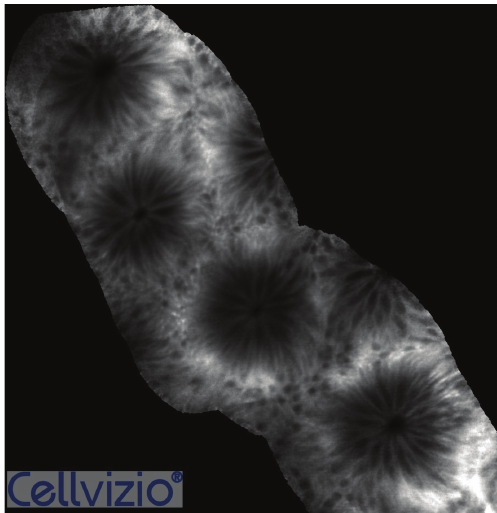
Figure 1: p-CLE fluorescein sodium 10% imaging of the normal colon showing hexagonal, honeycomb appearance with a regular-ordered network of capillaries demarcating the luminal crypt orifice. Surface crypt architecture was classically represented by ordered and regular crypt orifices covered by a homogeneous epithelial layer with visible “black-hole” goblet cells within the subcellular matrix.